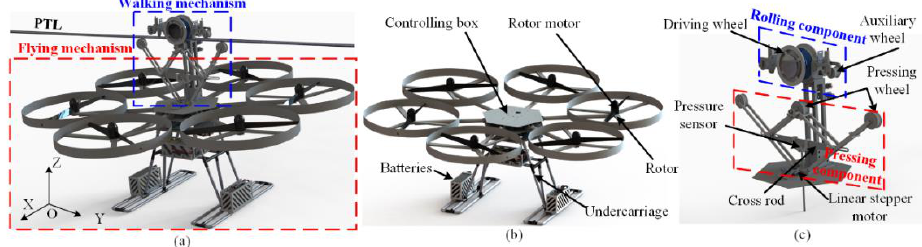
Figure 1. Schematic diagram of robot structure. ( a ) complete machine structure; ( b ) flying mechanism; ( c ) walking mechanism.